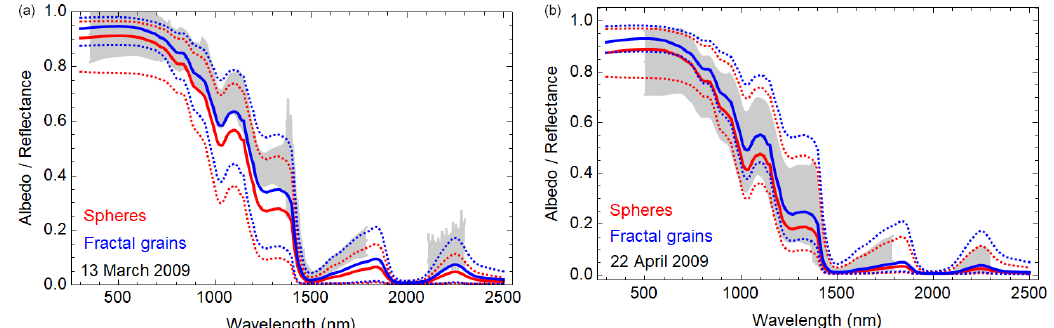
Figure 9. Variation range (grey) of the individual snow reflectance spectra measured using the ASD spectrometer in Hirviäkuru (67.38 ◦ N, 26.85 ◦ E) on 13 March and in Mantovaaranaapa (67.4 ◦ N, 26.72 ◦ E) on 22 April. The albedo simulations using the TARTES model are shown for fractal grains (blue) and spheres (red). The solid lines indicate the mean value and the dotted lines the minimum and maximum curves of the day in question. The ASD measurements were carried out in the same area as the grain size and density measurements, but the impurity measurements were daily values measured at Tähtelä (67.37 ◦ N, 26.63 ◦ E).